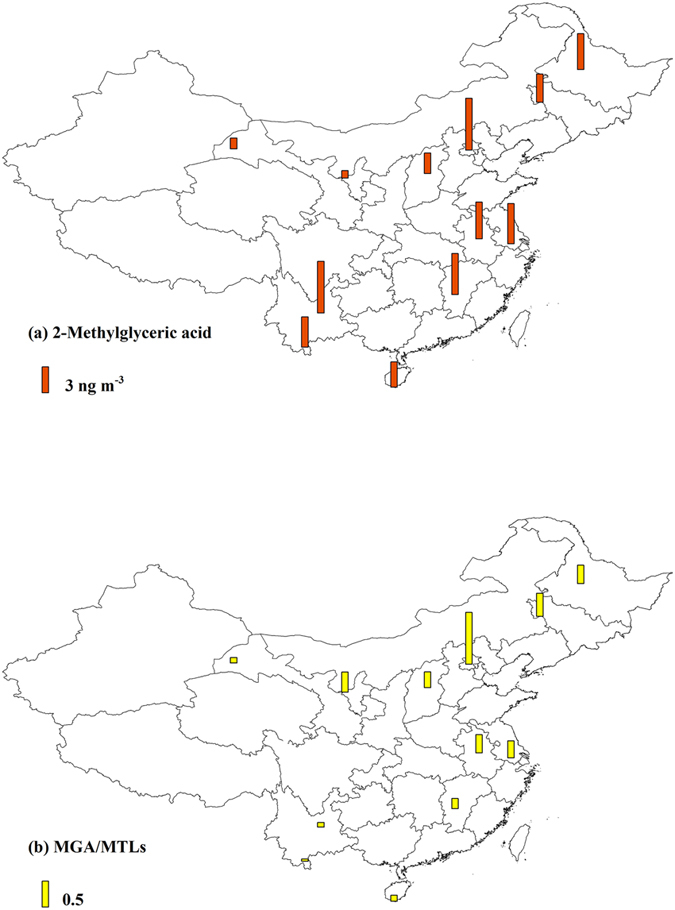
Spatial distribution of MGA and the ratio of MGA/MTLs in China.The figure is created by ArcGIS 10.1.